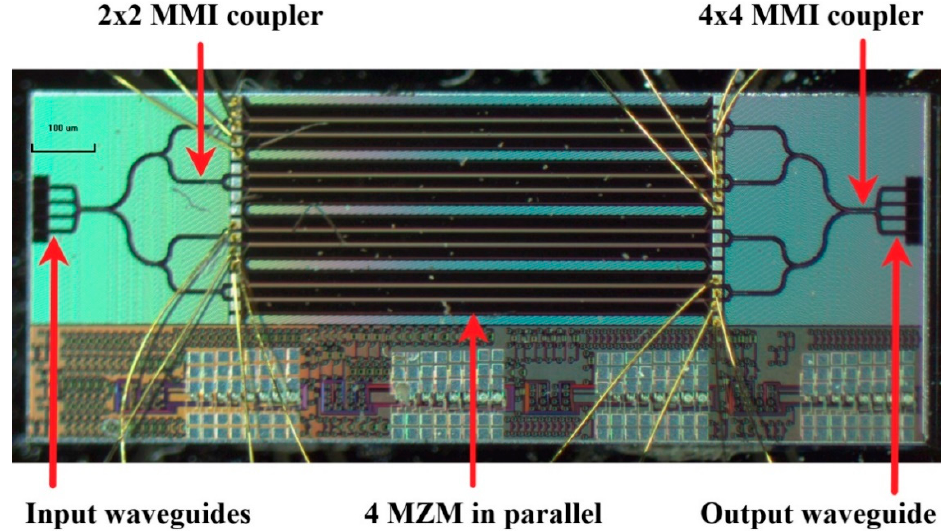
Figure 4. Top-view microscopic image of the fabricated